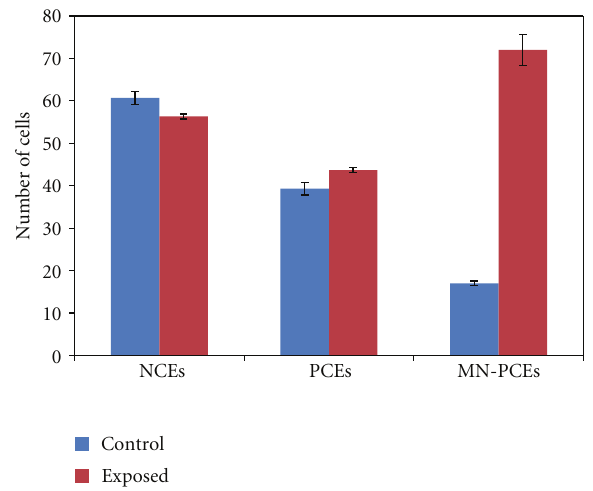
Figure 5: Micronucleus induction, NCE, PCE, and MN-PCE, in bone marrow cells of control newborn rats and those exposed to 50Hz and 0.5 mT MF for 30 days 24h/day. Mean ± S.E. ( P < 0 . 01, 0.001) for PCE and MNPCE, respectively.